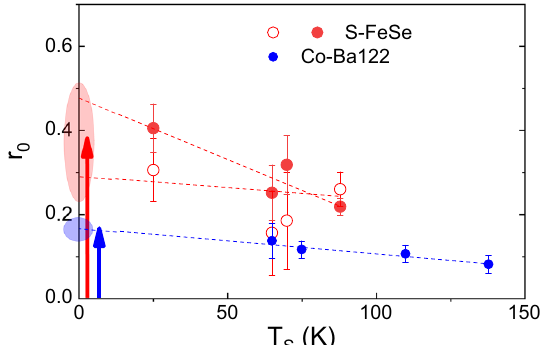
Fig. 5 Lattice-shifted nematic quantum criticality. Dimensionless as a function of T s for nemato-electron – lattice coupling r 0 = k B ð T s (cid:2) T 0 Þ E F FeSe 1 − x S x and Ba(Fe 1 − x Co x ) 2 As 2 50 . The Fermi energy E F was taken to be 20 and 40 meV for FeSe 1 − x S x and Ba(Fe 1 − x Co x ) 2 As 2 , respectively. For FeSe, full (empty) circles correspond to r 0 values deduced from T QEP ( T 400cm (cid:2) 1 ). By de fi nition the origin of the graph corresponds to 0 0 the location of the QCP in the absence of any coupling to the lattice ( T s = T 0 ), the arrows illustrate the effect of the lattice on the QCP. The line is linear fi t of r 0 ( T s ) used to deduced r 0 ( T s = 0), and the fi lled ovals illustrate their associated